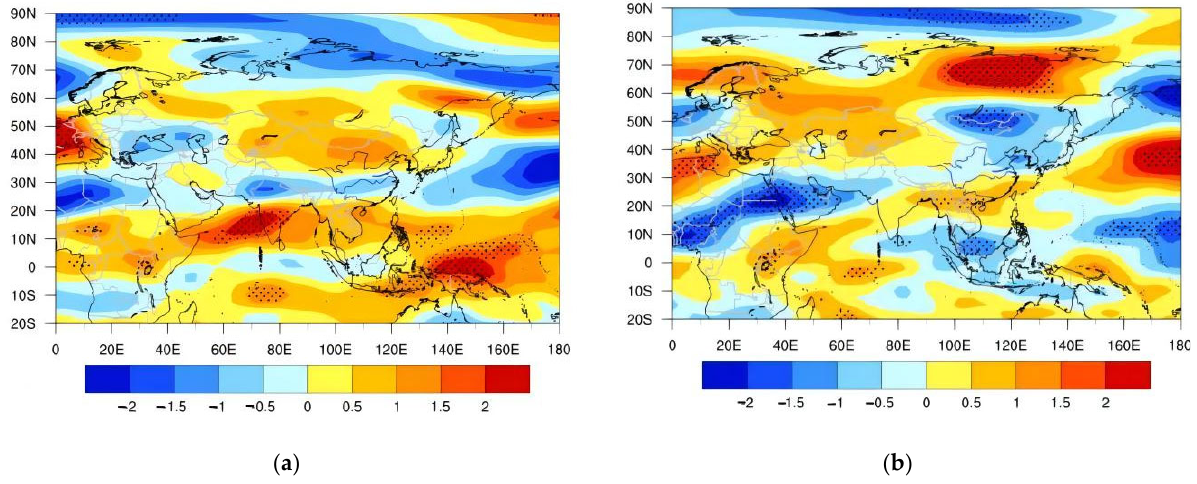
Figure 12. Differences between high and low SRF years of 500 hPa zonal wind field ( a ) in winter and ( b ) in spring. Stippling indicates the grid points that passed the 0.1 significance test. (Units: latitude is °N , and longitude is °E).